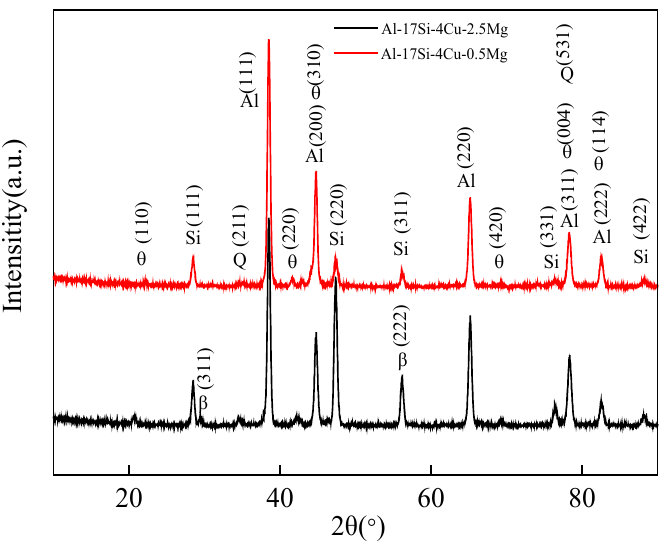
Figure 6. XRD curves for Al − 17Si − 4Cu − xMg alloys.